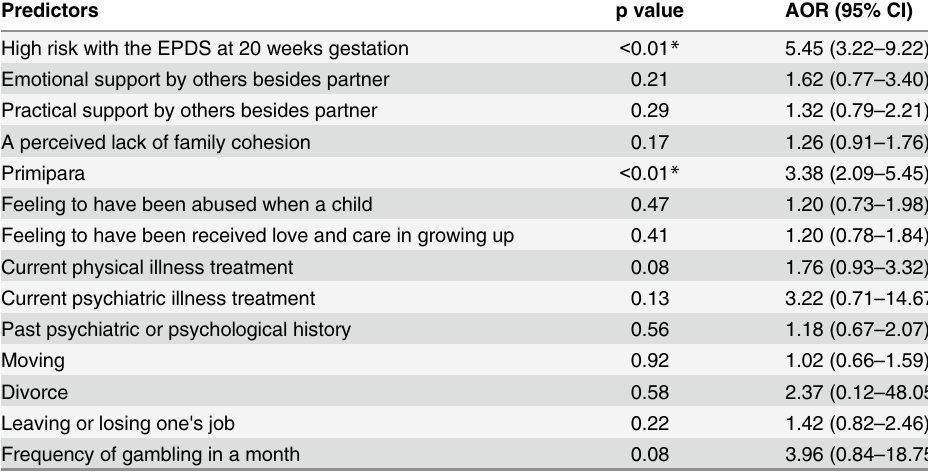
Leaving or losing one's job Frequency of gambling in a month